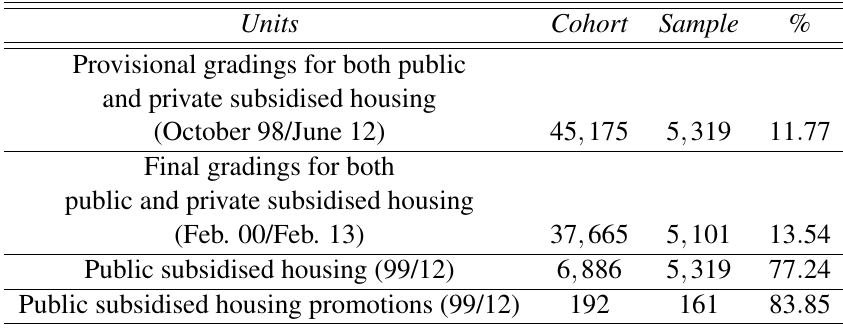
Table 2 Sample and cohort concerning Castilla-La Mancha (Spain) subsidised housing. Source: own